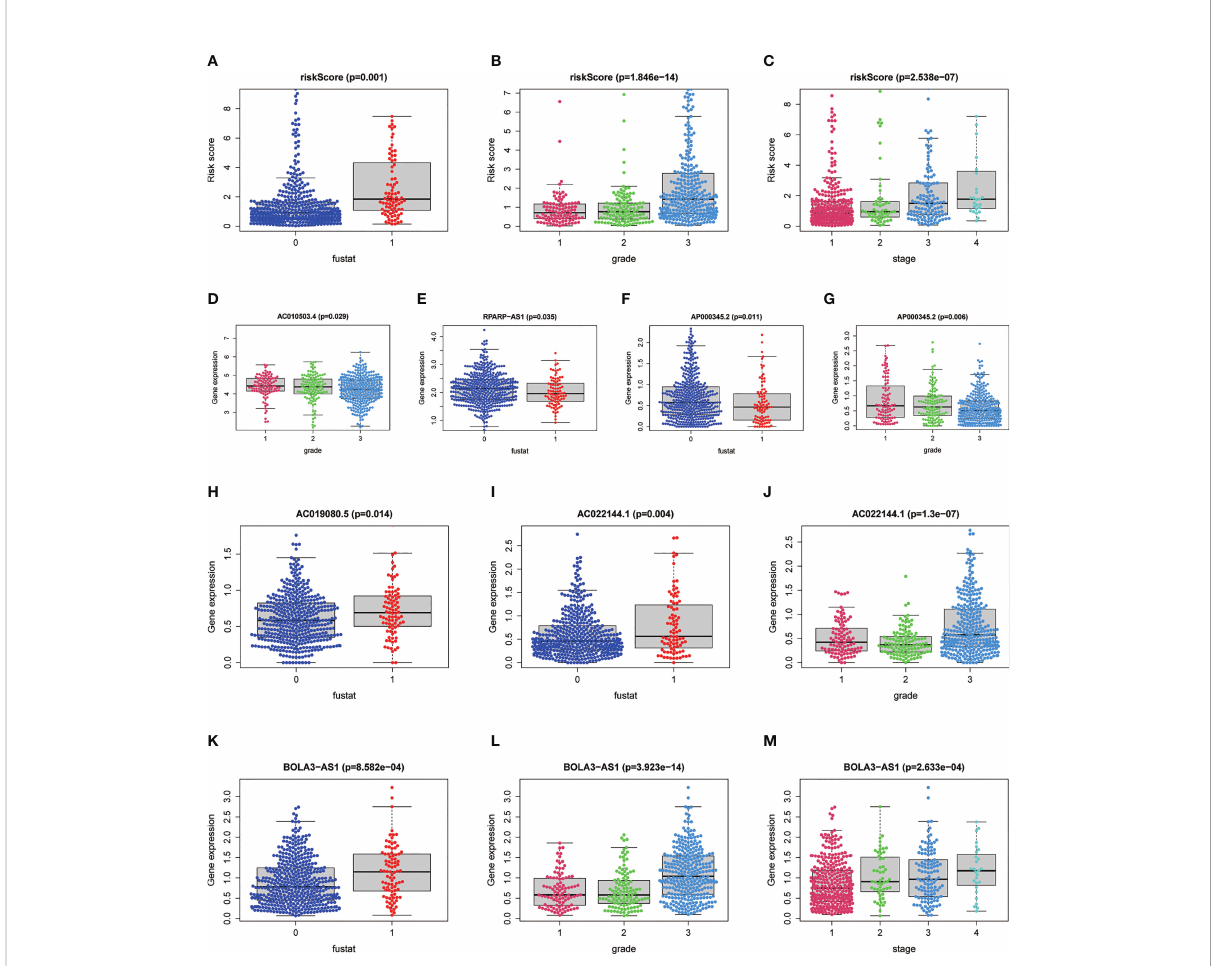
FIGURE 8 Correlation between risk score and seven prognostic lncRNAs as well as clinicopathological variables. (A – C) Risk scores correlated with survival status, grade, and stage. (D) Expression level of AC010503.4 correlated with grade. (E) Expression level of RPARP-AS1 correlated with survival status. (F, G) Expression level of AP000345.2 correlated with grade and survival status. (H) Expression level of AC019080.5 correlated with survival status. (I, J) Expression level of AC022144.1 correlated with grade and survival status. (K – M) Expression level of BOLA3-AS1 associated with grade, stage, and survival status, respectively.